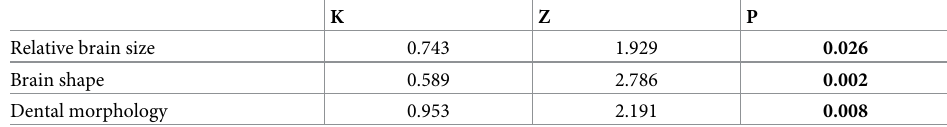
Table 2. Tests of phylogenetic signal in brain size and shape and dental morphology.